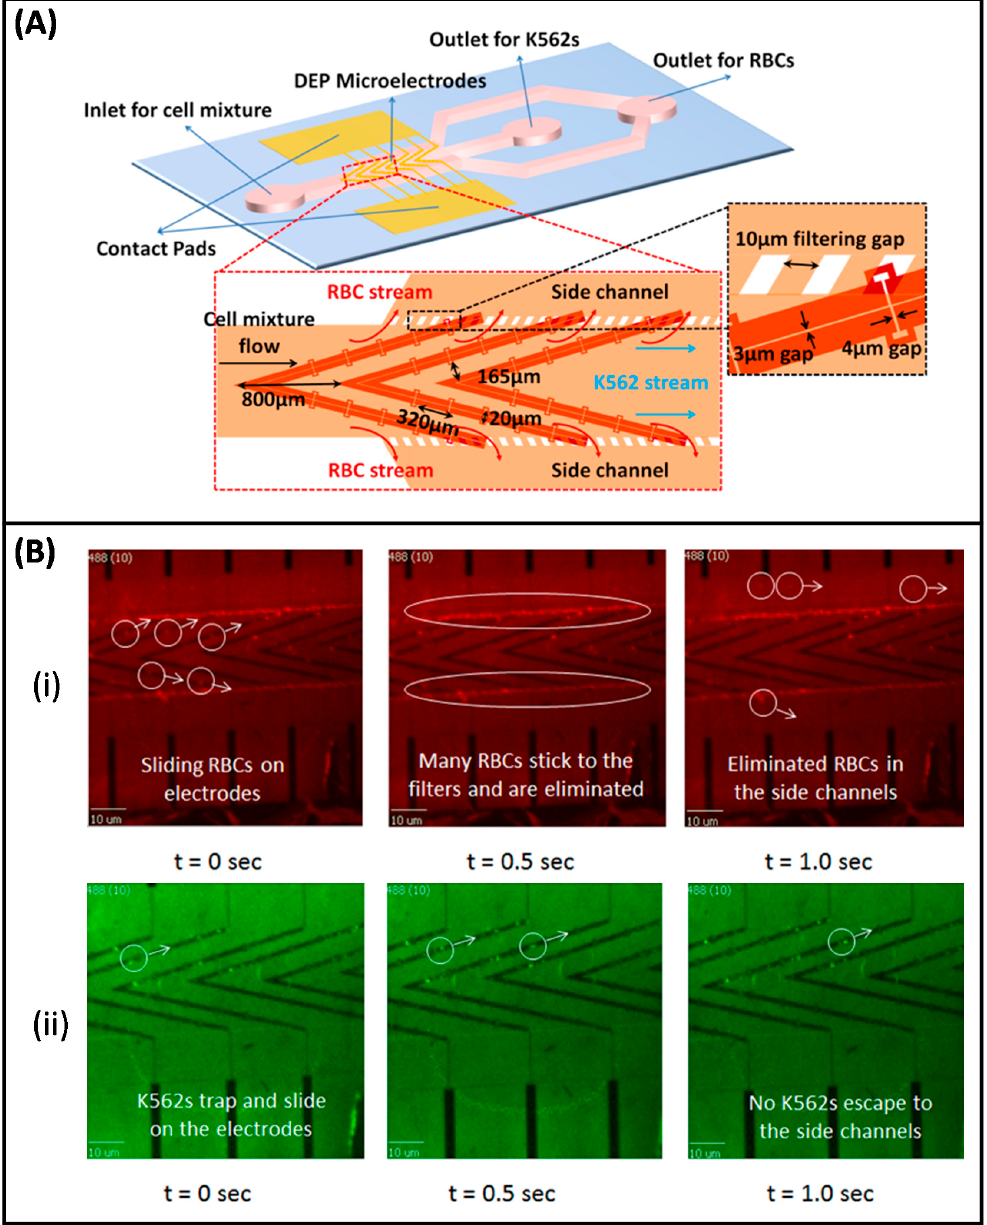
Figure 5. ( A ) Schematic of the device. ( B ) Experiments were performed with a flow rate of 30 µ L / min at 20 V pp , 1 MHz. Manipulation of the RBCs stained with Cell Tracker Red ( i ), and K562 cancer cells stained with fluorescein diacetate ( ii ). All cells were directed to the side walls via pDEP by sliding over the electrodes. While the RBCs passed through the filters, the K562 cells moved through the main channel because they could not pass the filters [225]. Copyright 2017, Elsevier.